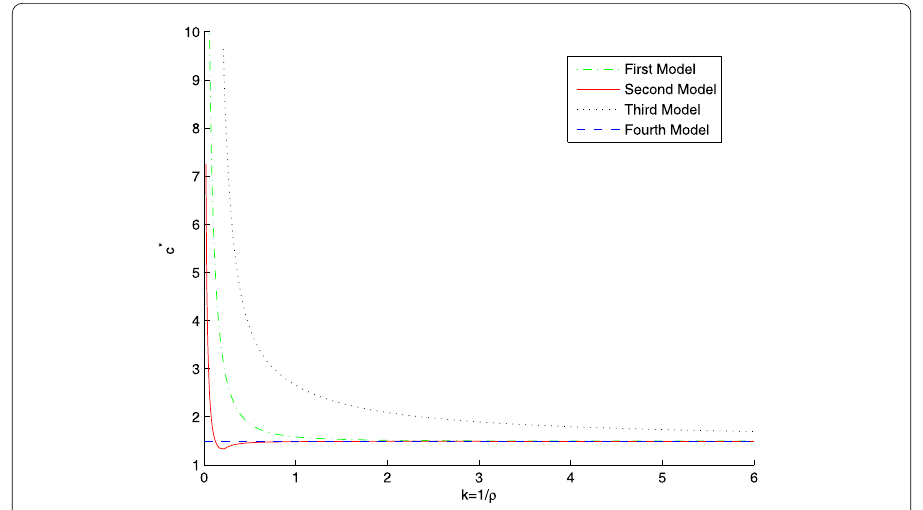
Figure 1 The curves of c ∗ ( k ). Let F ( S , I ) = β S ∗ I , α = 1, β = 3, S 0 = 1, γ = 1.5 m and τ = 1 be fixed. Additionally, d 2 = 4 and d 3 = 7. We can see that the minimal wave speed c ∗ of the first, second, and third models converges to the minimal wave speed of the local reaction case as k = 1 ρ →